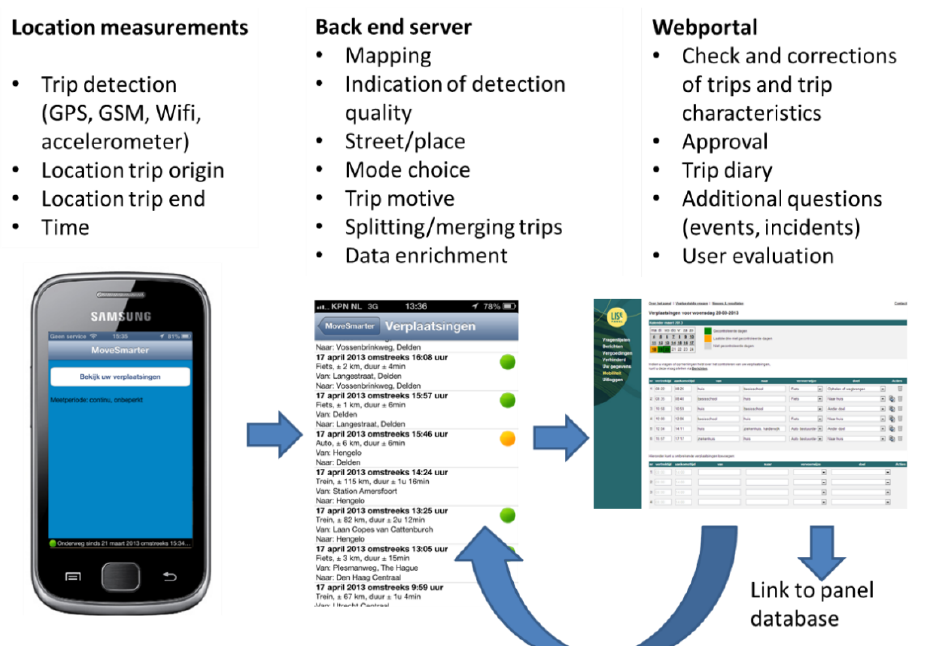
Figure 1. Movesmarter app - data collection overview (Geurs et al.,